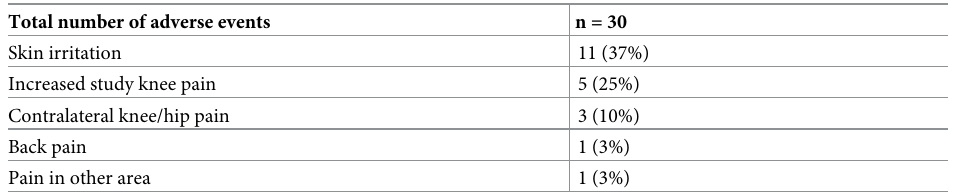
Table 5. Adverse events, n